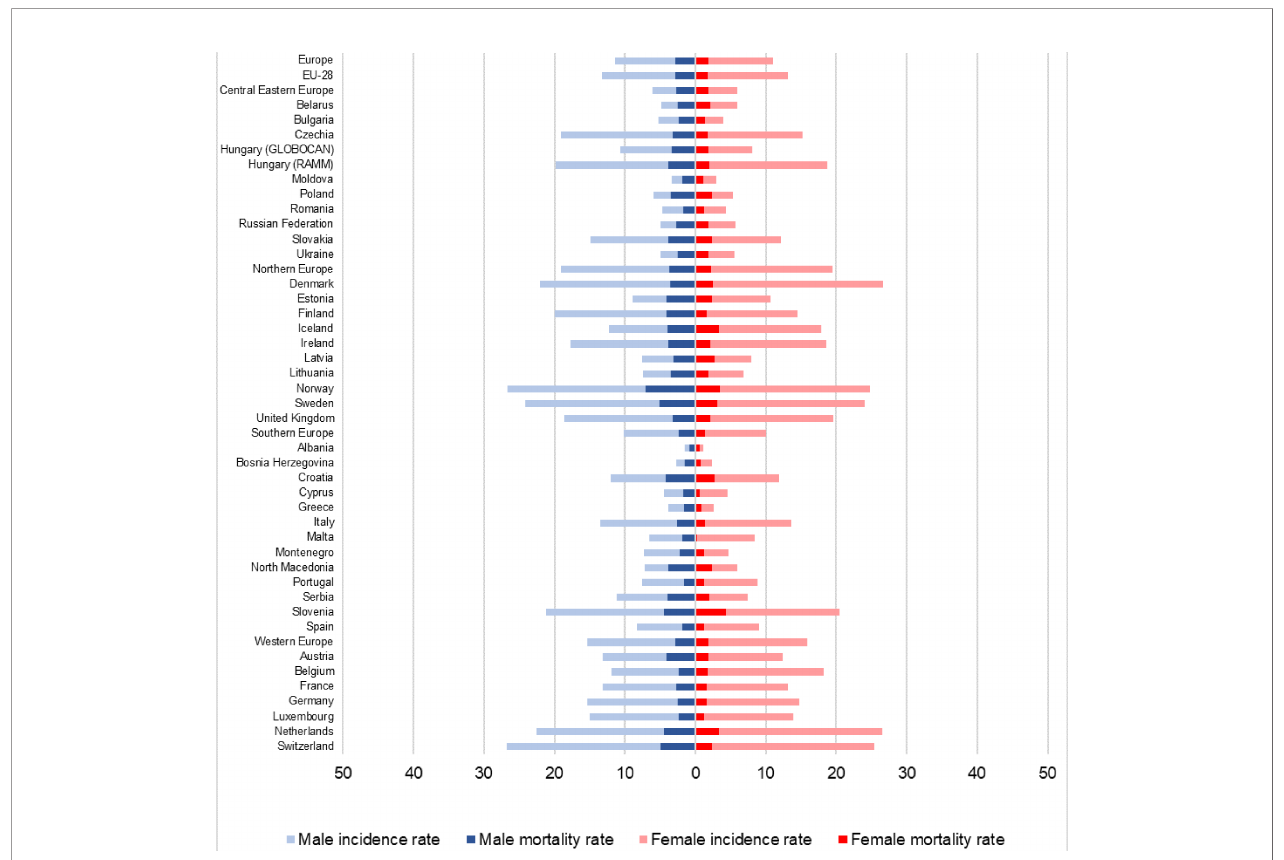
FIGURE 5 | Age-standardized melanoma incidence and mortality rates by sex in Europe, 2018 (ESP 1976